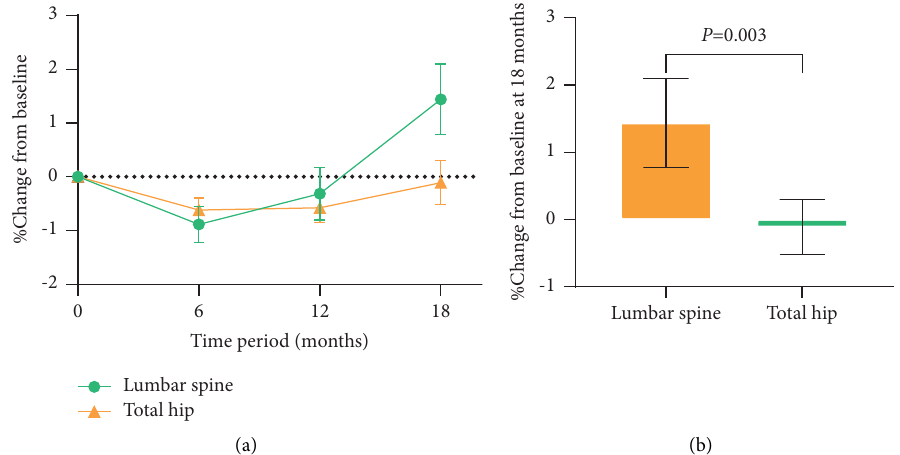
Figure 5: Diferences in percentage change in BMD of the lumbar spine and total hip. (a) Changes in BMD of the lumbar spine and total hip over an 18-month treatment period; (b) diference in change between lumbar spine BMD and total hip BMD at the 18th month. P < 0 . 01 for the lumbar spine BMD compared with the total hip BMD (Wilcoxon test). Te results are presented as the mean ±